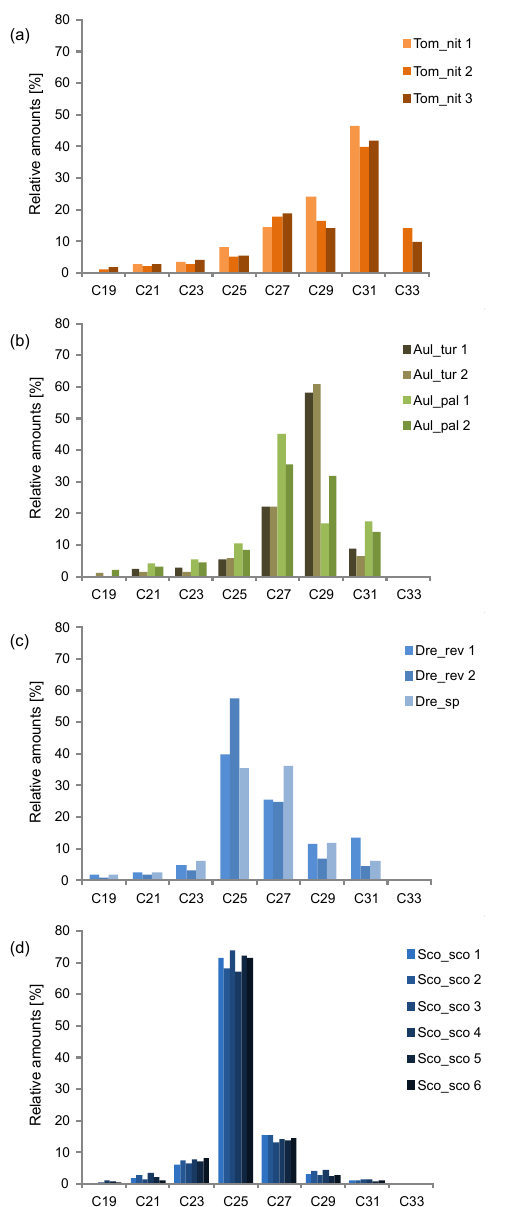
Figure 4. The relative amounts (%) of n -alkanes with an odd num- ber of carbon atoms in selected brown mosses, grouped by species and ordered by their preferences with respect to their mean plant position relative to water level for xero-mesophilic (a, b) and meso- hygrophilic (c, d) mosses. Tom-nit: Tomentypnum nitens ; Aul_tur: Aulacomnium turgidum ; Aul_pal: Aulacomnium palustre ; Dre_rev: Drepanocladus revolvens ; Dre_sp: Drepanocladus sp.; Sco_sco: Scorpidium scorpioides .